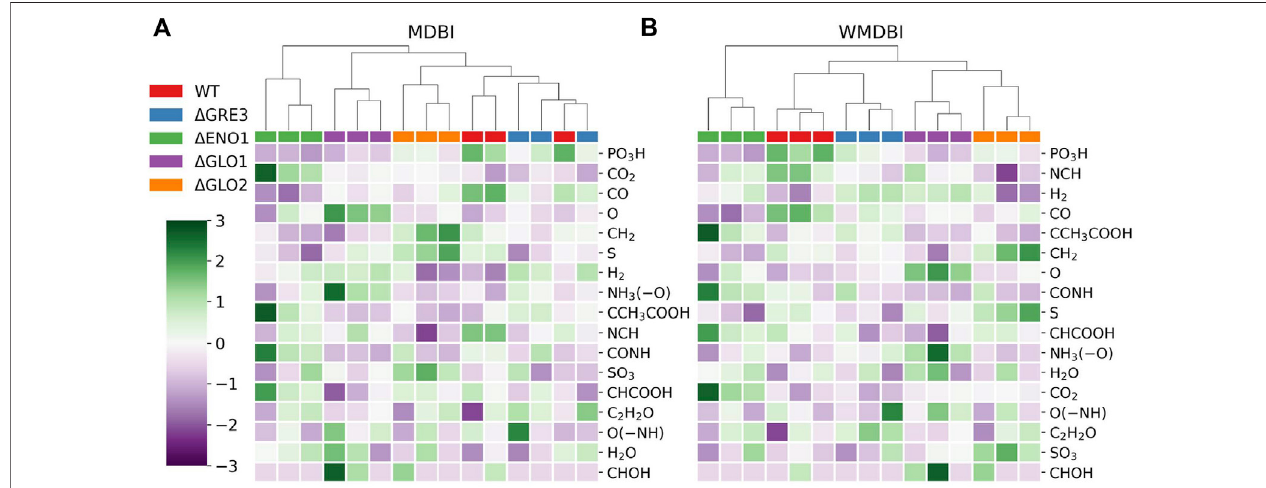
FIGURE 5 | MDBI and WMDBI values for the sMDiNs of the YD dataset. (A) MDB impact; (B) weighted MDB impact. Values were mean-centered and standard scaled. MDBs are ordered by decreasing gini importance. Samples are triplicates of yeast strains of the wild-type reference strain (WT) and four single-gene deletion isogenic mutants of this strain: Δ GLO1, Δ GLO2, Δ GRE3, and Δ ENO1. MDBs are listed in Table 2 . Samples were clustered by HCA, with Euclidean distance and Ward